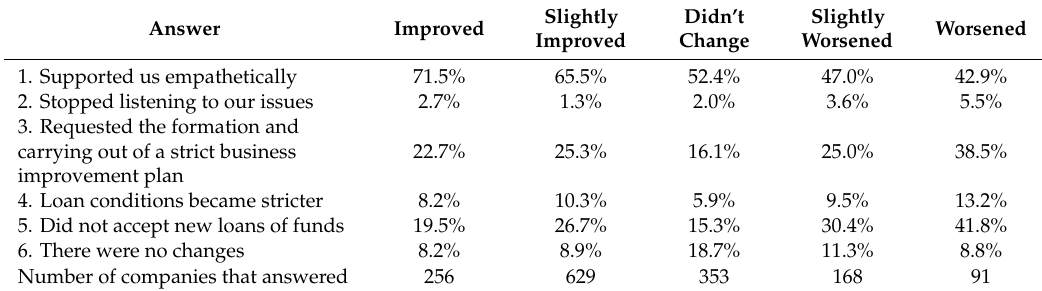
Table 10. The Attitude of financial institutions after condition